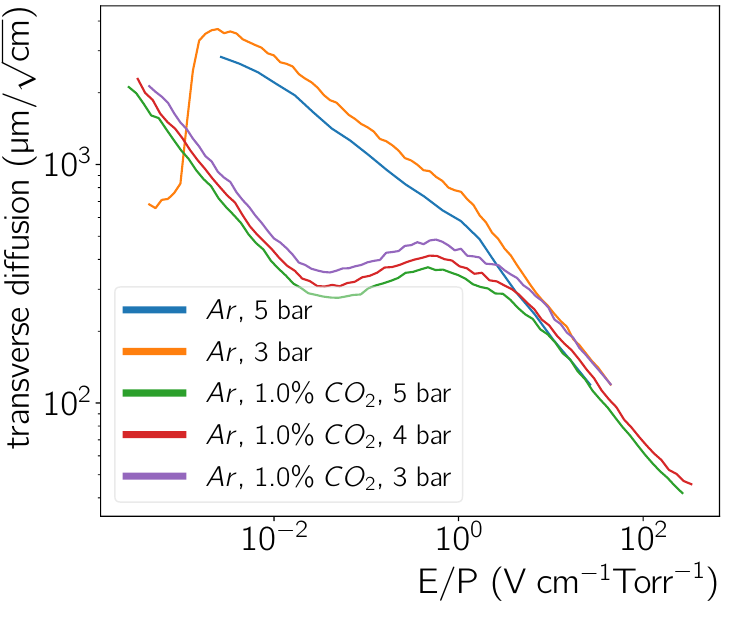
Figure 2. Transverse diffusion for pure argon and different Ar/CO 2 mixtures that were simulated using M AGBOLTZ